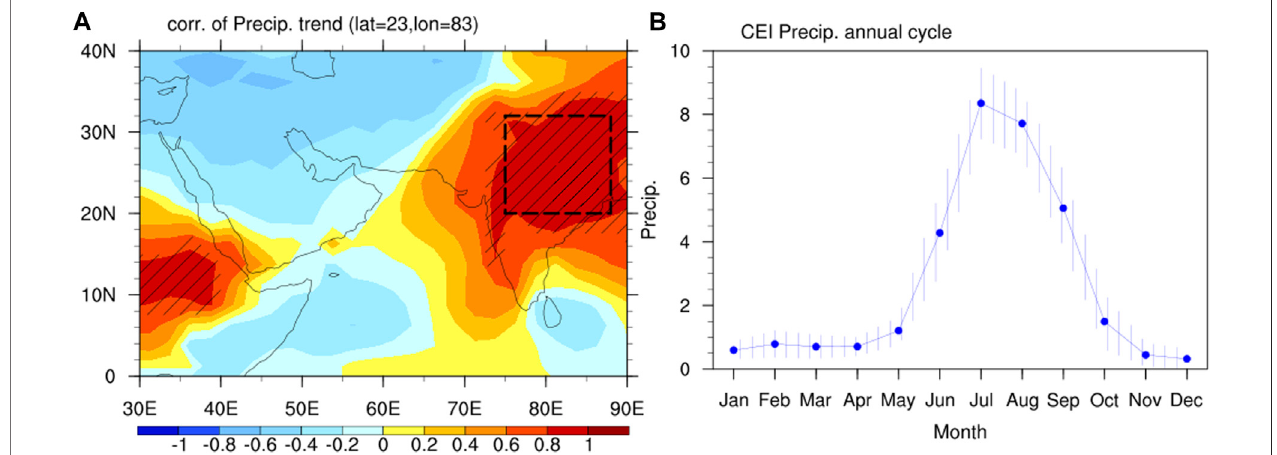
FIGURE3|(A) Theone-pointcorrelationpatternofprecipitationatthecentralgridoftheISMregion(23 ° N,83 ° E)withthatatallotherpointsand (B) theannualcycle of CEI regional averaged precipitation (mm/day). The hatched black lines in Figure 3A represent the value with statistically signi fi cant at 0.01 level. The box with black dashed lines in Figure 3A indicates the CEI (20 – 32 ° N, 75 – 88 °